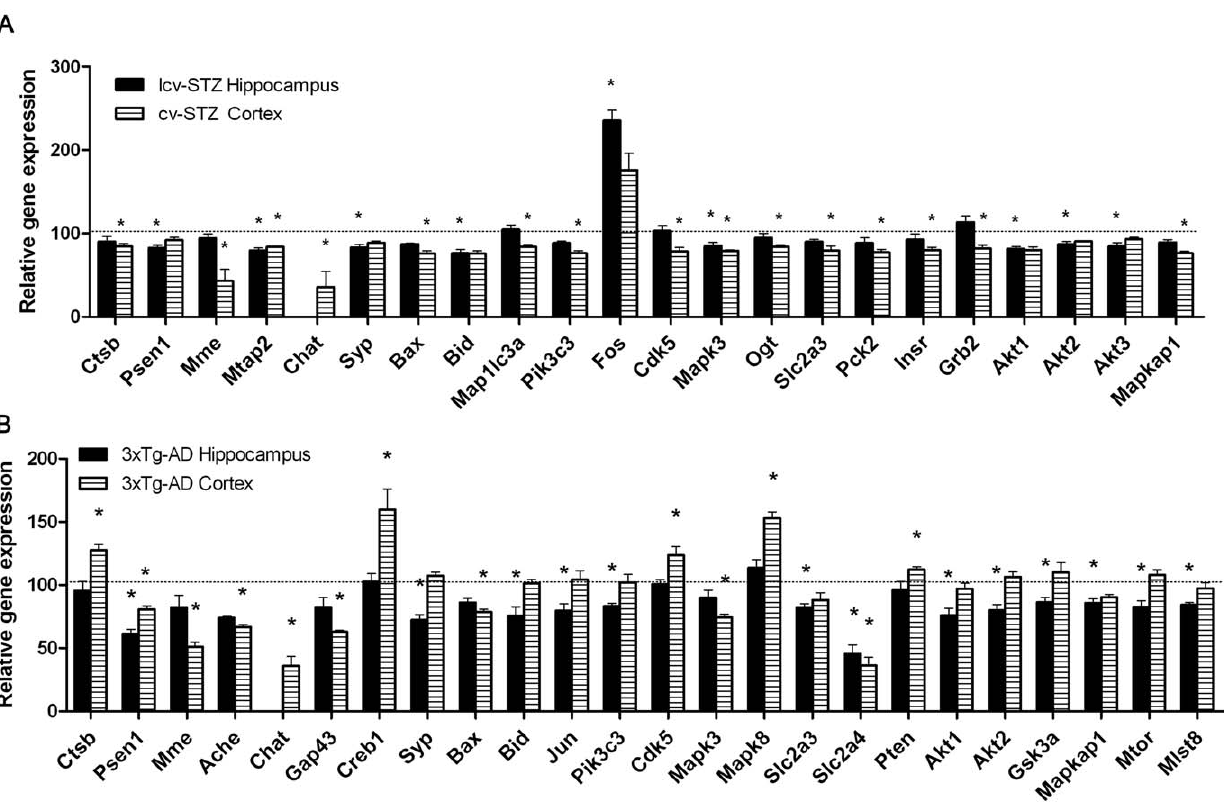
Figure 10. Comparison of altered AD-related gene expression profiles between the hippocampus and cerebral cortex. The relative levels of gene expression are shown, where those of the control mice are defined as 100. The hippocampal Chat data were excluded because of the high C t values (30 , Ct , 37) that indicated unreliable data.